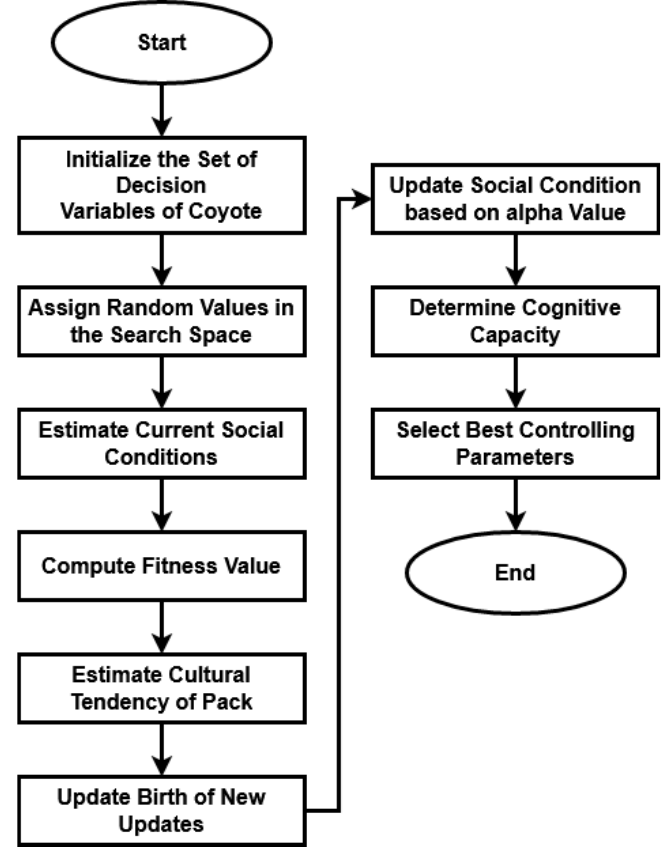
Figure 6. Flow of the CO algorithm.